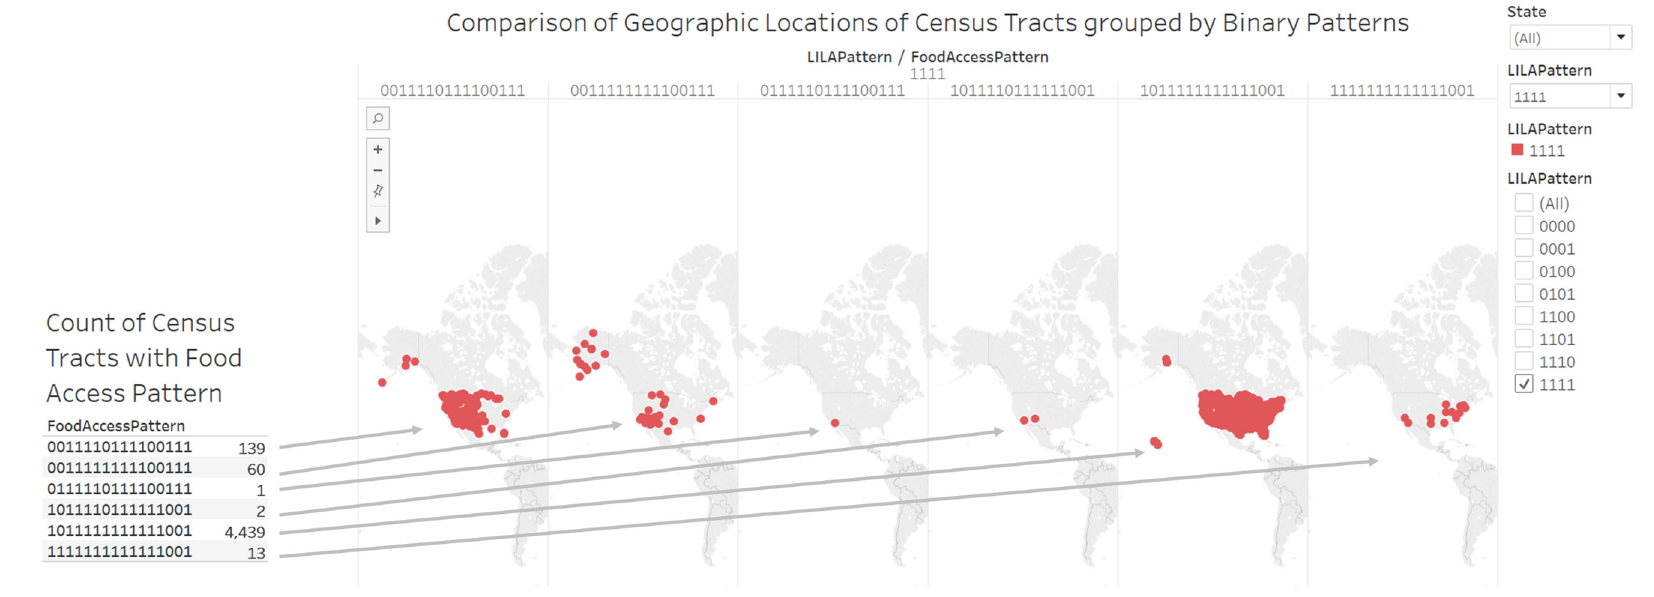
Figure 6. Comparison of geographic locations of census tracts grouped by binary patterns. In this example, there are six binary numbers that describe census tracts that have low income low access (attention function of knowledge visualization). The geographic map can support decision making on census tracts with specific food access pattern (motivation function of knowledge visualization).